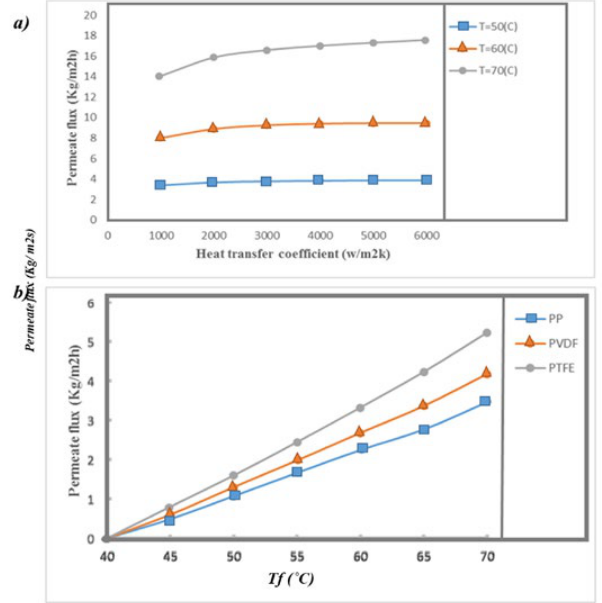
Fig. 3: a) The heat transfer coefficient influence on the distillate flux, b) Effect of feed temperature on the distillate flux for the three hydrophobic membranes.